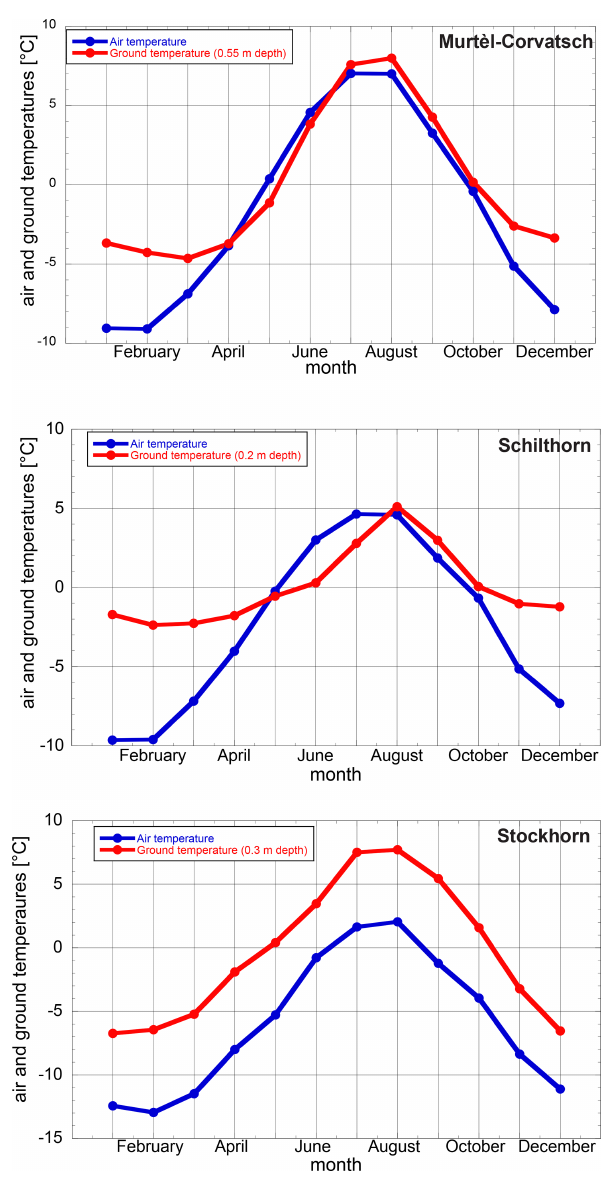
Figure 11. Monthly thermal offsets for all three stations for the whole observation periods: Murtèl–Corvatsch (1997–2018), Schilthorn (1999–2018) and Stockhorn